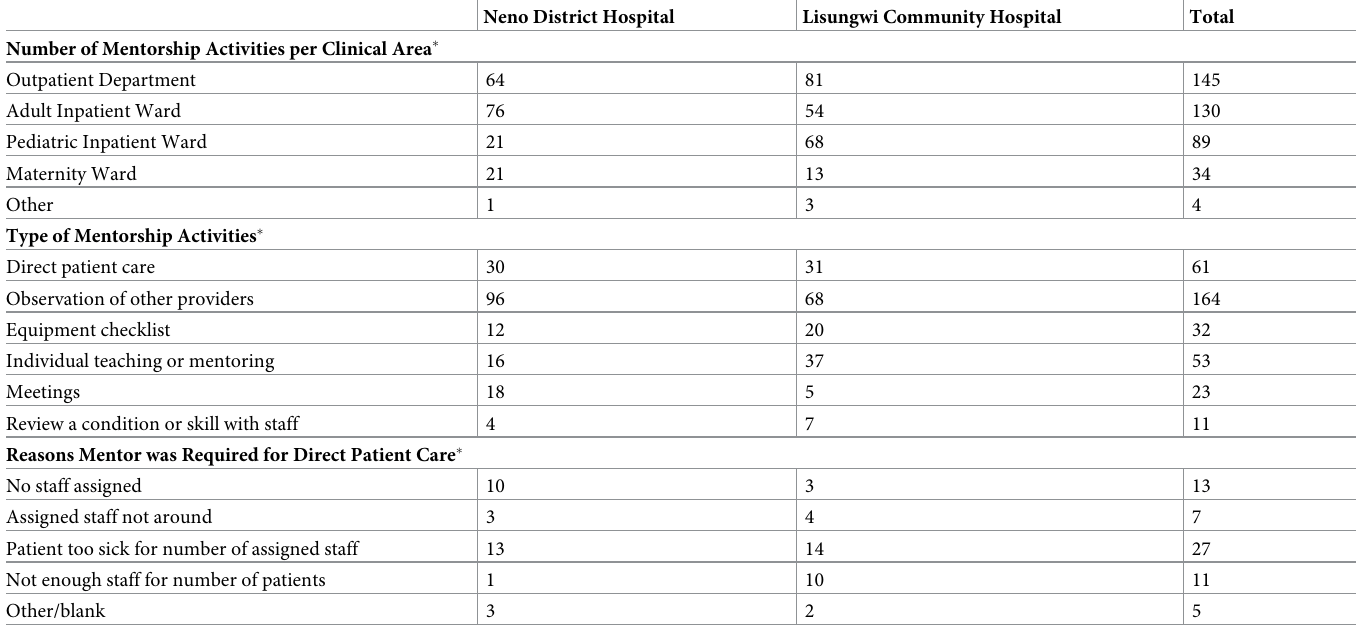
Table 3. Mentorship